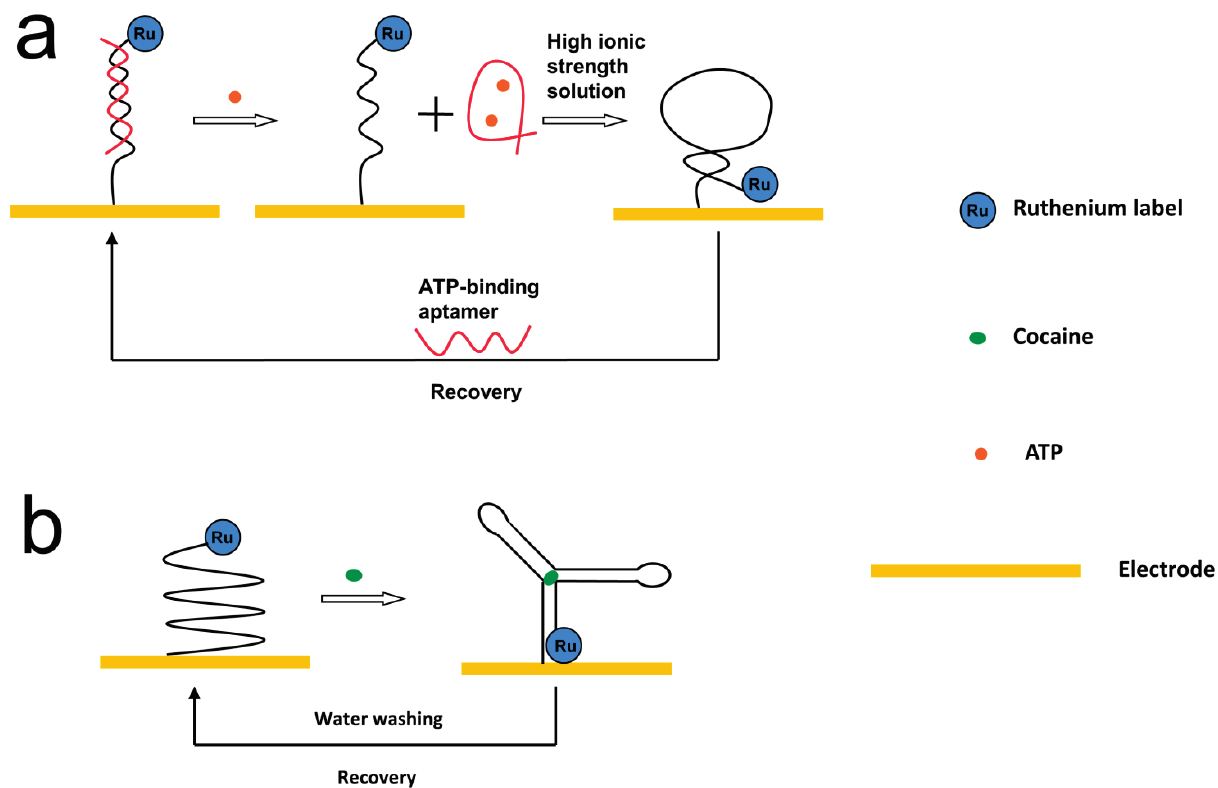
Figure 16. Reusable ECL aptasensor for small molecules detection using Ru(bpy) 32+ as ECL luminophore. ( a ) adapted with permission from ref. [87], copyright (2009) Elsevier; ( b ) adapted with permission from ref. [209], copyright (2010) American Chemical